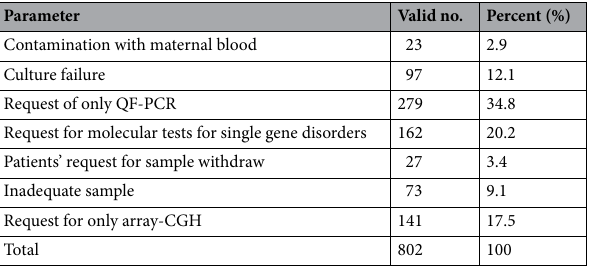
Table 1. Reasons for lack of karyotype data in a proportion of performed